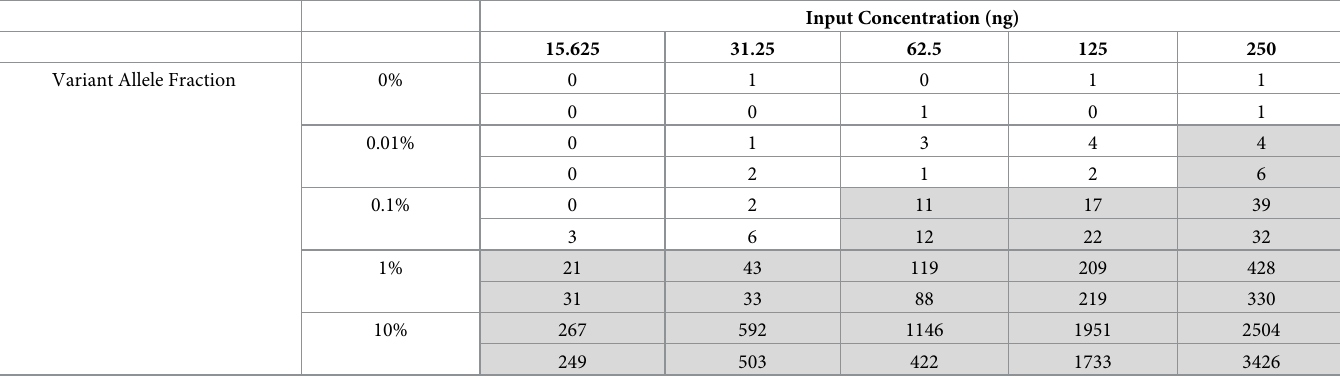
Table 2. Number of positive mutant events for EGFR L858R reactions.